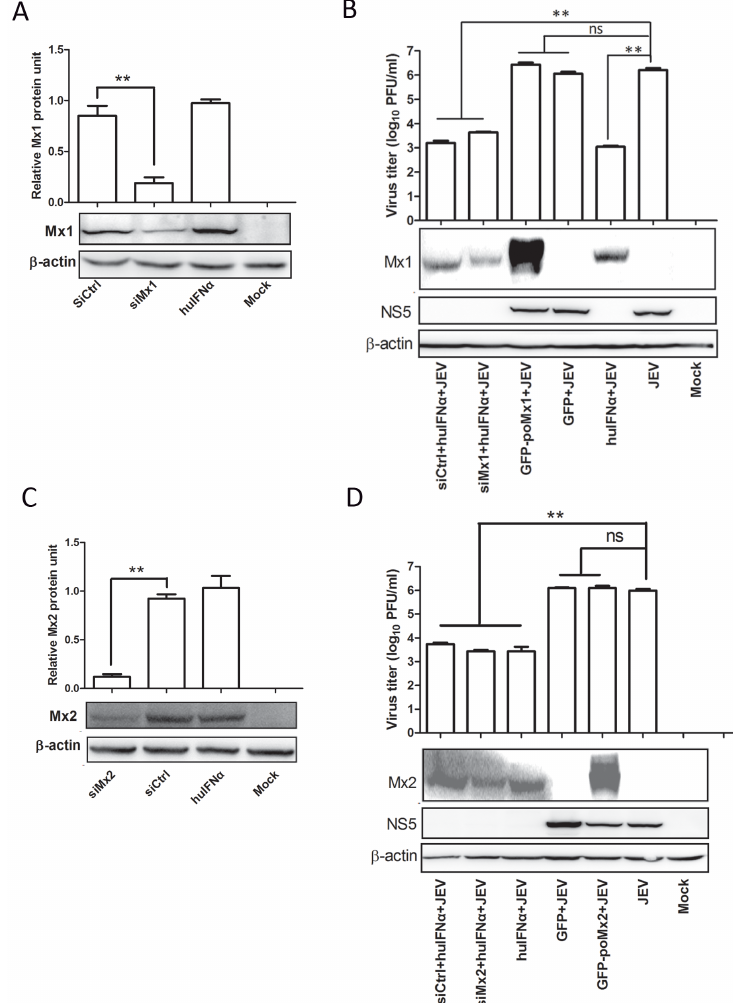
Figure 5. IFN α inhibits JEV replication in Mx ‐ knockdown BHK ‐ 21 cells. Cells were transfected with